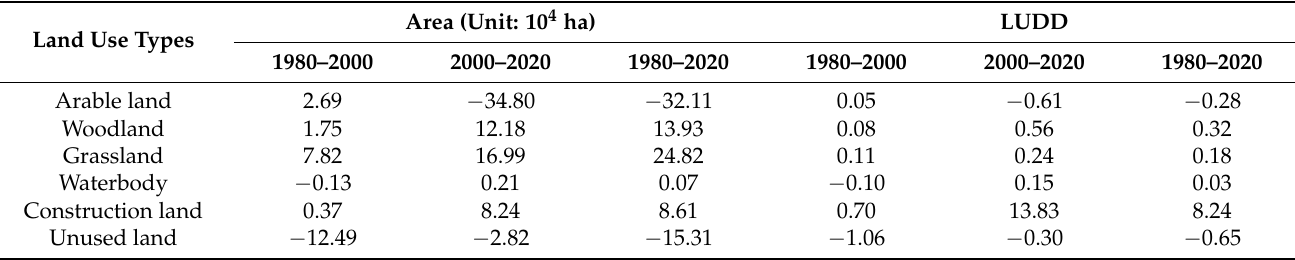
Table 2. Changes in the area and land-use dynamic degree (LUDD) for the Loess Plateau of northern Shaanxi in 1980–2000 and